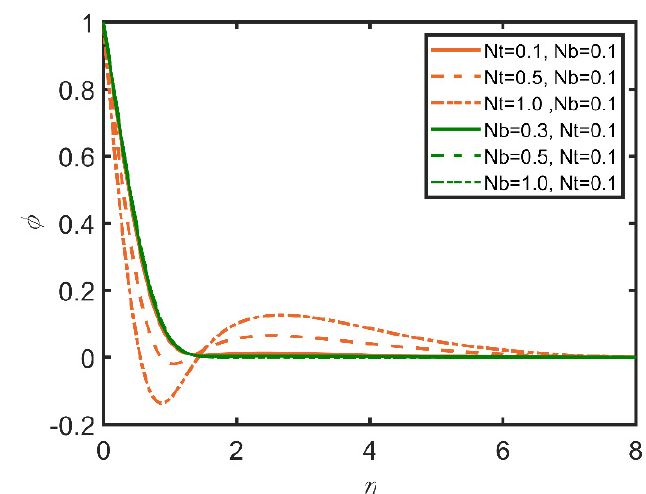
Figure 6. Comparison for concentration profile against 𝜂 .